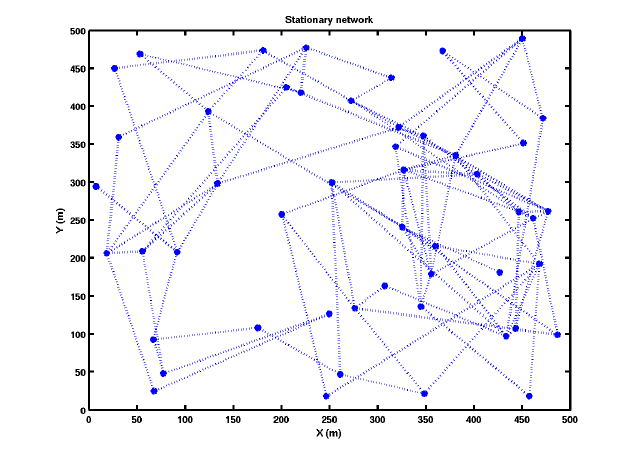
Figure 7. A simulated environment has stationary network nodes through which a MAV may travel. Network connectivity is indicated by dotted lines. Note that due to the nature of RF communication, connectivity is not geographical. Similarly, as the MAV travels around the network, the node to which it can communicate may